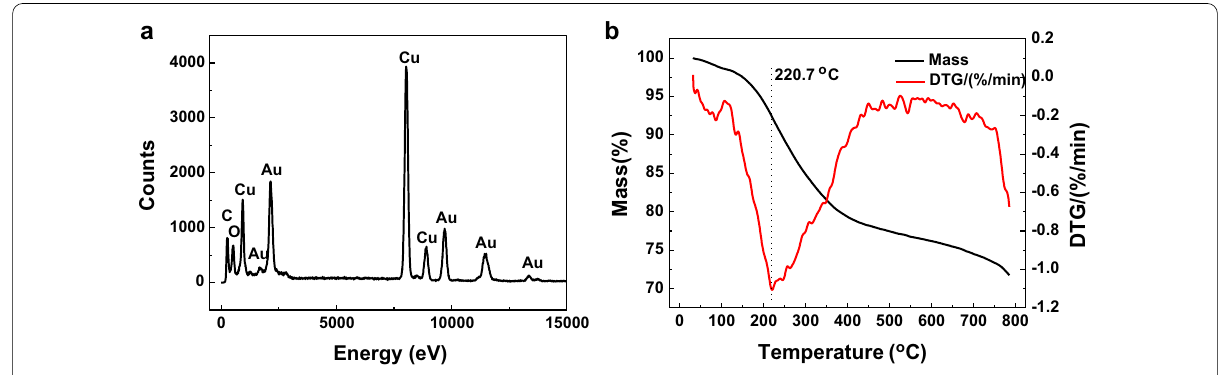
Fig. 5 EDS spectrum ( a ) and TG ( b ) profiles of gold